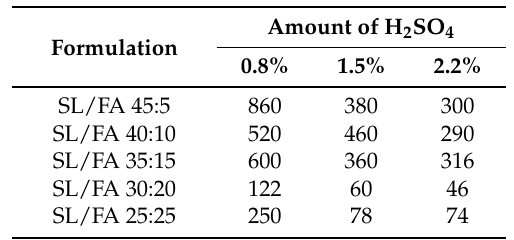
Table 2. Gel-time in seconds of SL/FA formulations hardened with different amount of catalyst Polymers 2016 , 8 , 396 at 100 ◦ C.